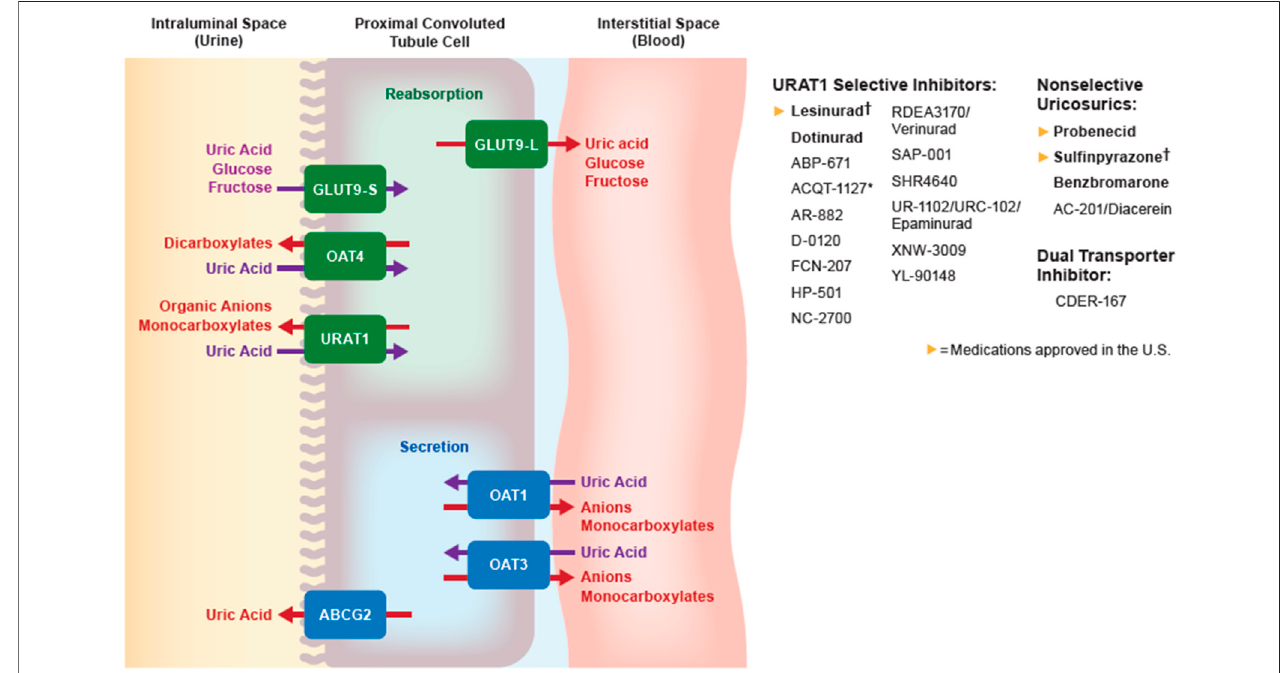
FIGURE2| Uratetransportasomeintheproximalconvolutedtubule;medicationsinboldareapprovedbytheFDA,EMA,orPDMA. † denotesmedicationsthatare approved but nolongermanufactured.ABCG,ATPbinding cassette subfamily G;GLUT,Glucosetransporter; OAT, Organicanion transporter(L,long;S,short);URAT, Urate